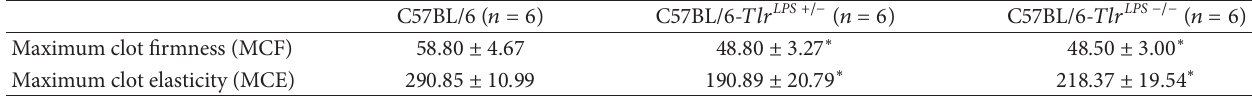
Table 8: The platelet component of clot strength in experimental